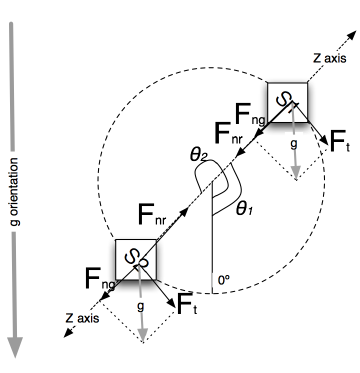
Figure 5. Diagram of forces.